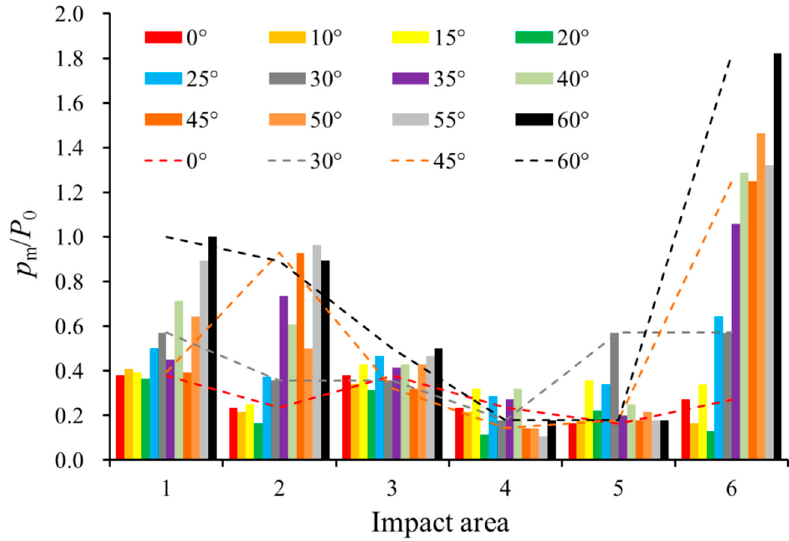
Figure 10. Pressure distributions in the plunge pool affected by the inclined floor angle α .